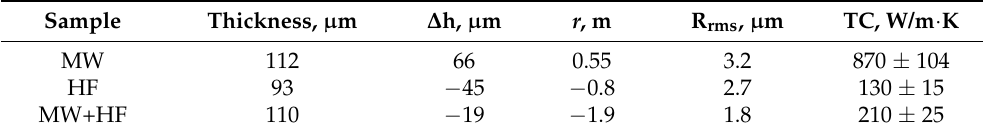
Figure 5. Bow of the grown samples as measured by white light interferometer ZYGO NewView5000 from the substrate (bottom) side of the samples. Table 1. Thickness, bow ∆ h, curvature radius r , roughness Rrms, and thermal conductivity TC of as-grown MW CVD, HF CVD, and MW+HF CVD